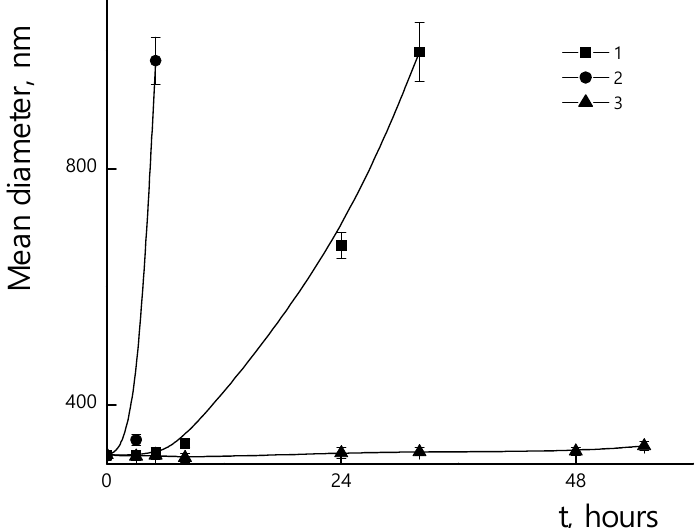
Figure 14. Mean hydrodynamic diameters of PLAMs–us suspensions with trypsin during incubation. Concentration of PLAMs 0.5 mg/mL, concentration of trypsin 4 mg/mL, Tris buffer with pH 7, temperatures 25 °C (1); 37 °C (2); 7 °C (3).